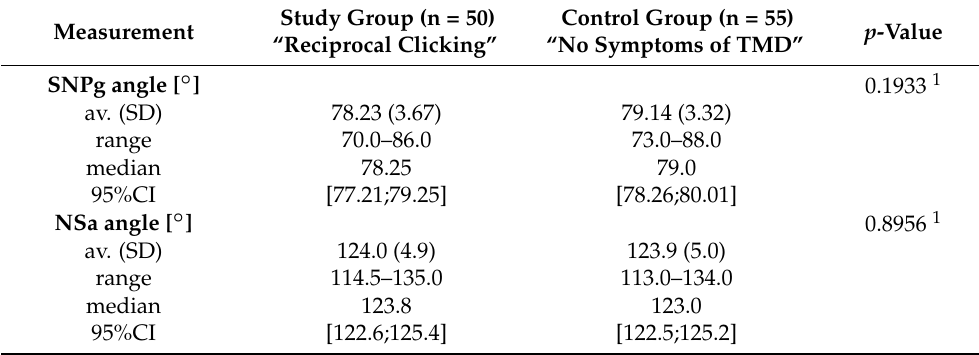
Table 6. Assessment of the position and morphology of the mandible in both groups.